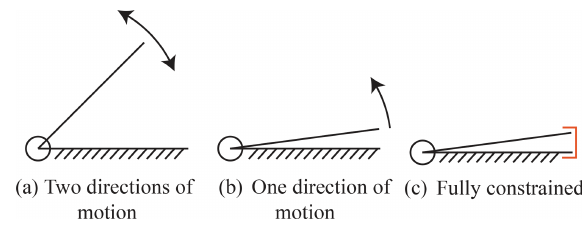
Figure 12. A crease can fold in two directions (a) until it reaches the fully folded state (b) . In the fully folded state the motion of one facet is limited by intersection with the other facet. An external constraint in the opposite direction fully constrains the crease (c) .